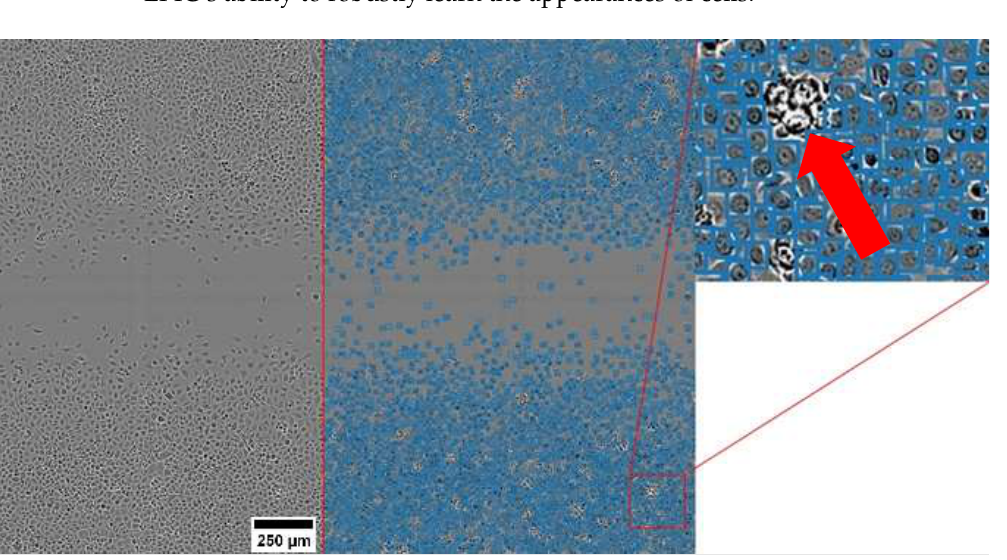
Figure 2. EPIC cell detection in a low-resolution and high-density wound repair image of the control experiment type. Left panel: unlabeled raw image, middle panel: same image with cell detections marked with blue bounding boxes, and right panel: enlarged region of middle panel showing accu- rate cell detections (blue boxes) and a large unlabeled region of cell debris (indicated by red arrow).